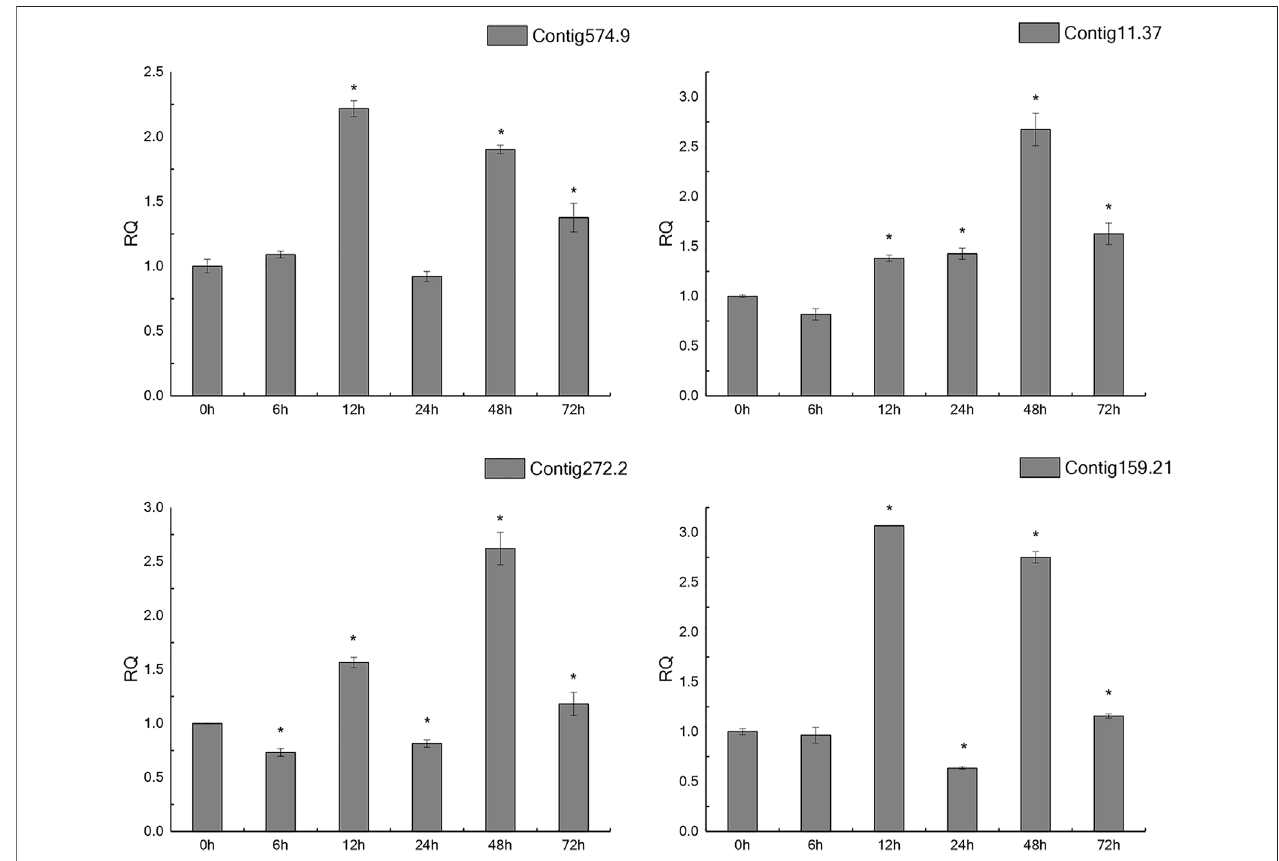
FIGURE 3 | qPCR results of salt-tolerant-related